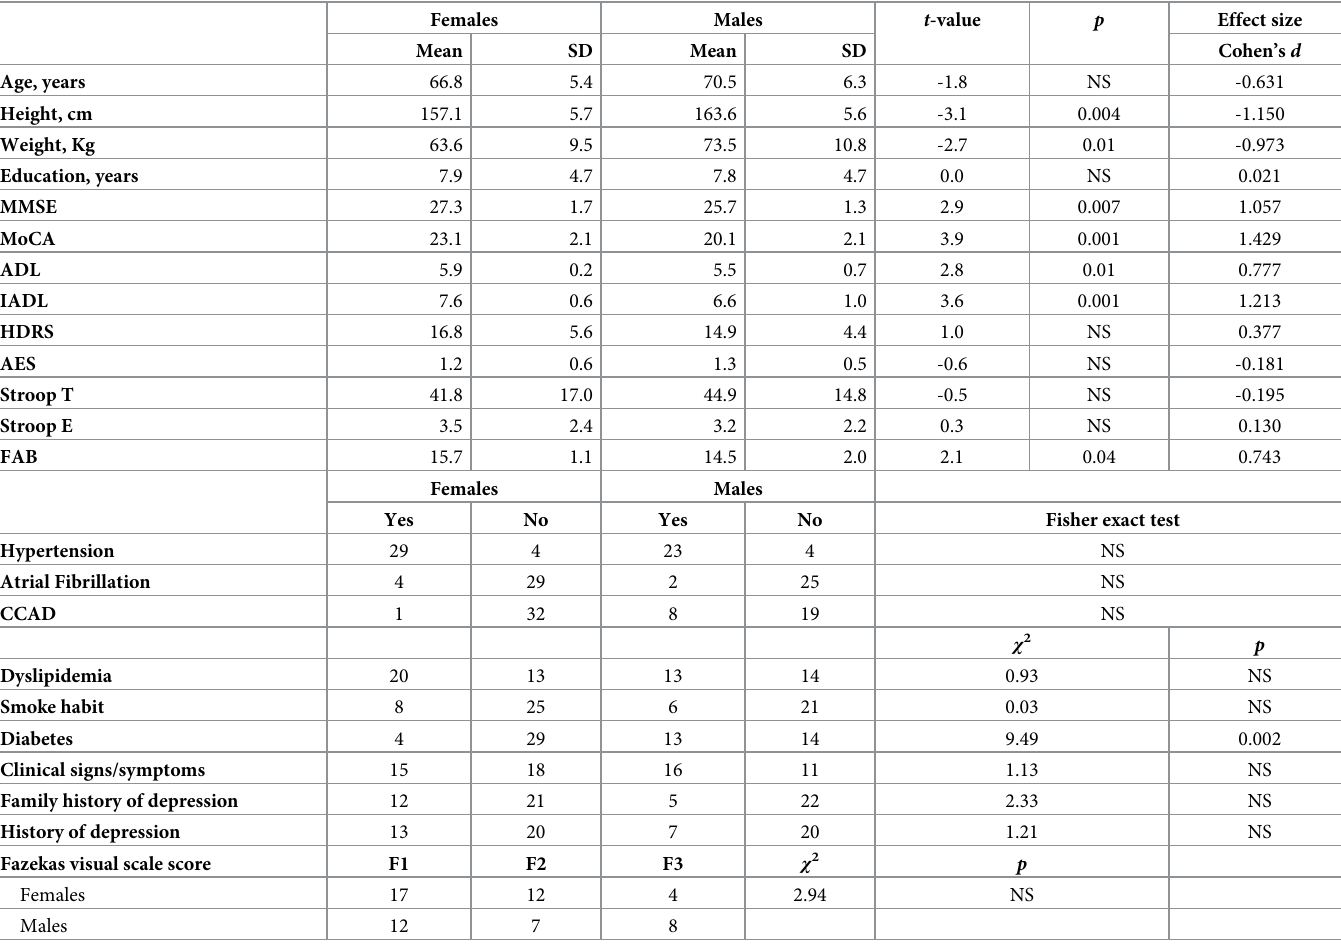
Table 1. Demographic, anthropometric, and psycho-cognitive features of male and female